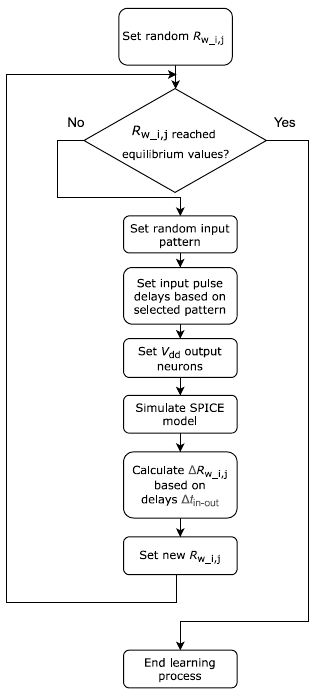
Figure 8. SNN training algorithm.